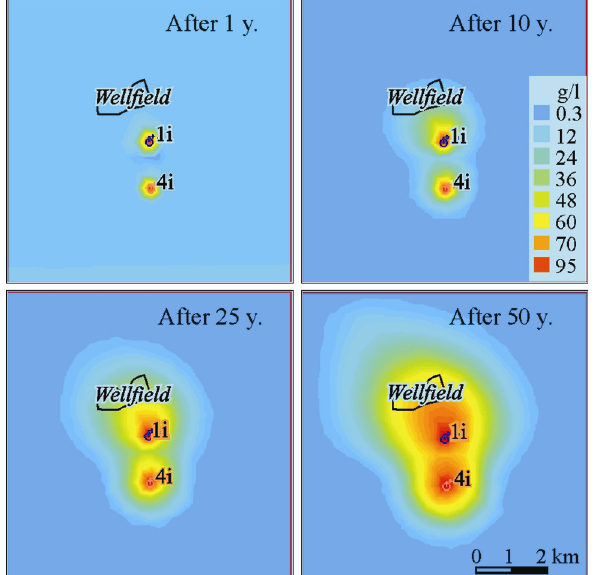
Fig. 10 . Mineralization of Upper Permian–Žagarė aquifer water after 1, 10, 25 and 50 years a potential emergency in the injec- tion well